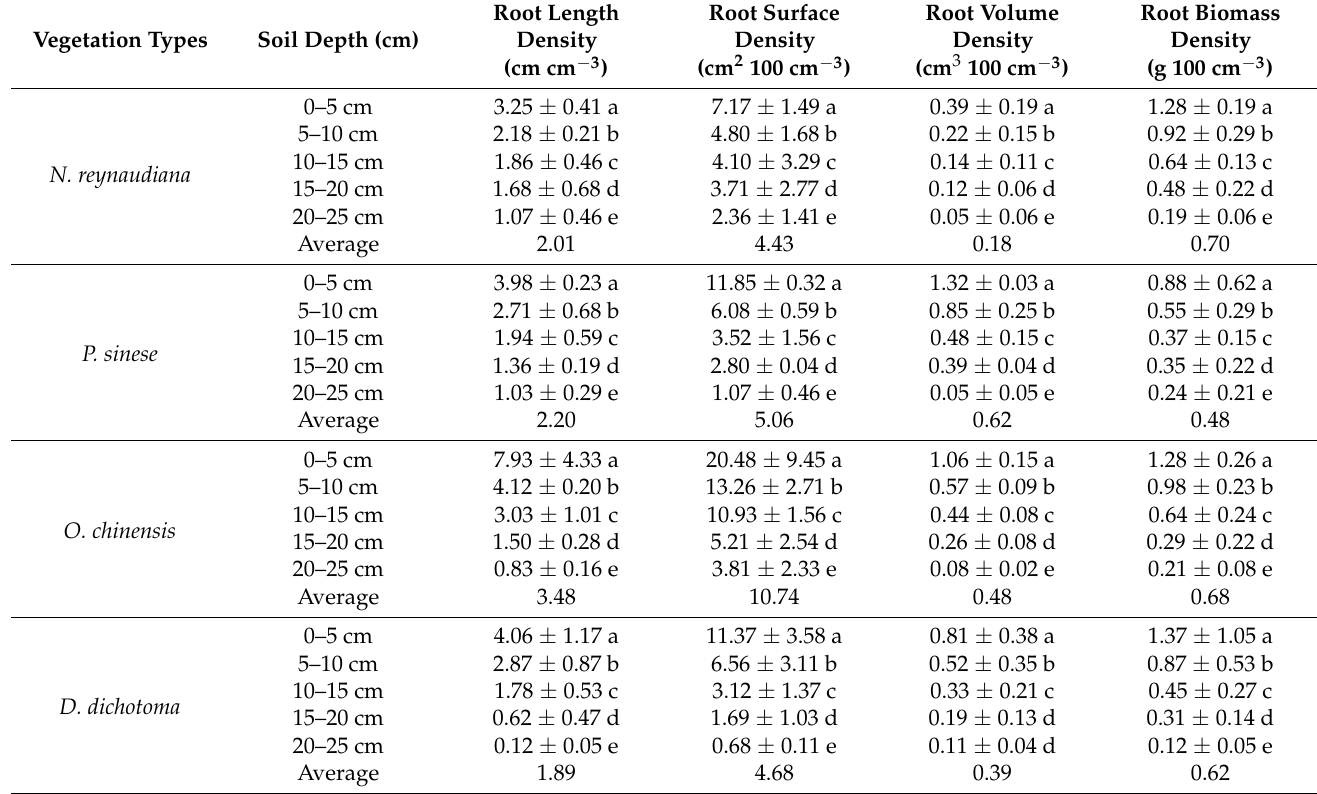
Table 4. Root morphological parameters of the four herbaceous plants.